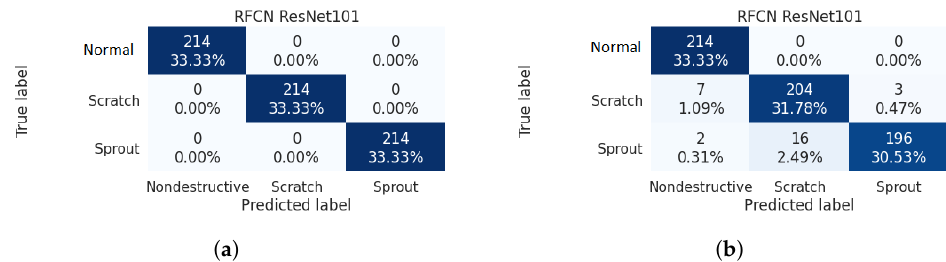
Figure 13. Confusion matrices for the OOS test set: ( a ) scenario one ( b ) scenario